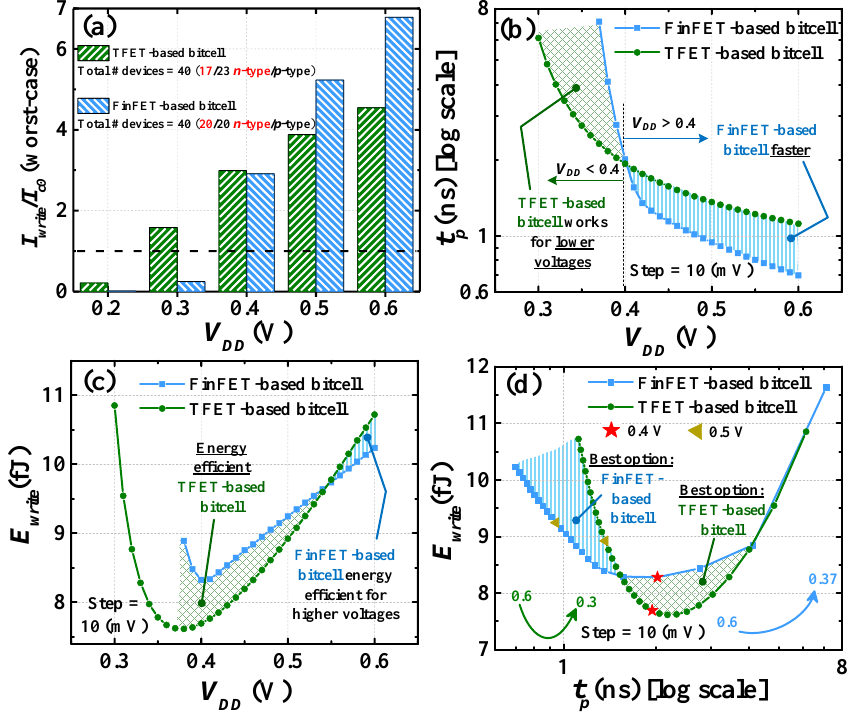
Figure 6. TFET- versus FinFET-based bitcell performance comparison in terms of: ( a ) I write / I c 0 ratio, ( b ) write pulse width, t p , at a write-error-rate of 10 − 7 , ( c ) average energy, E write , and ( d ) E write versus t p for different supply voltages. The V DD step is